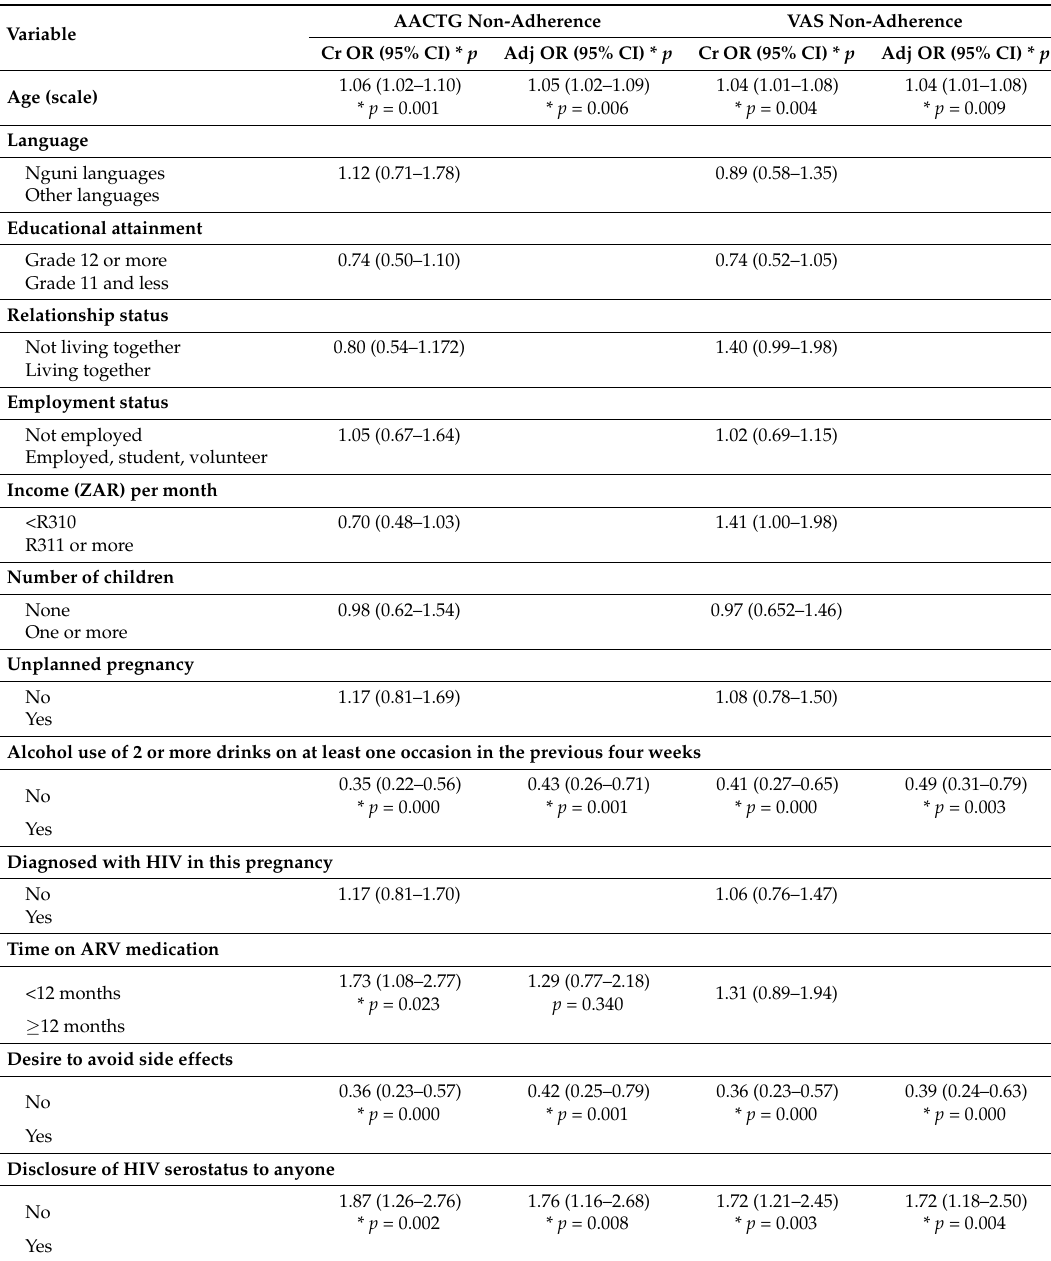
Table 3. Association of demographic, socioeconomic, health, and behaviour characteristics to ARV